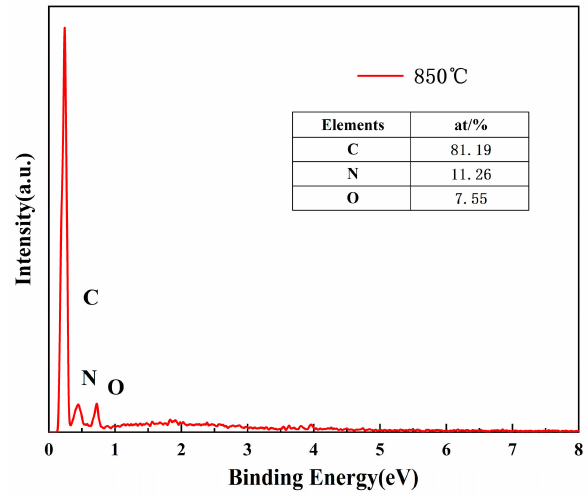
Figure 7. EDS spectrum of N-doped layered porous carbon at 850 ◦ C.